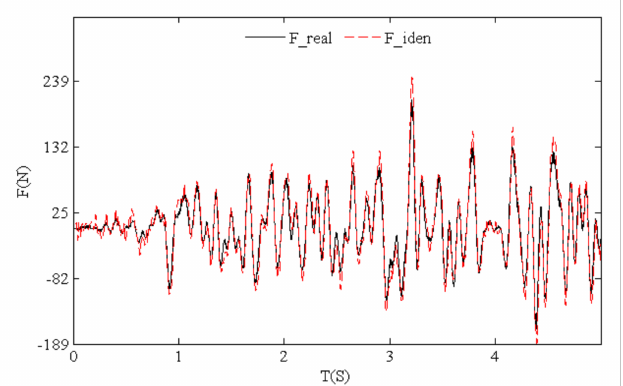
Figure 17. Time history of identified and real values for test random